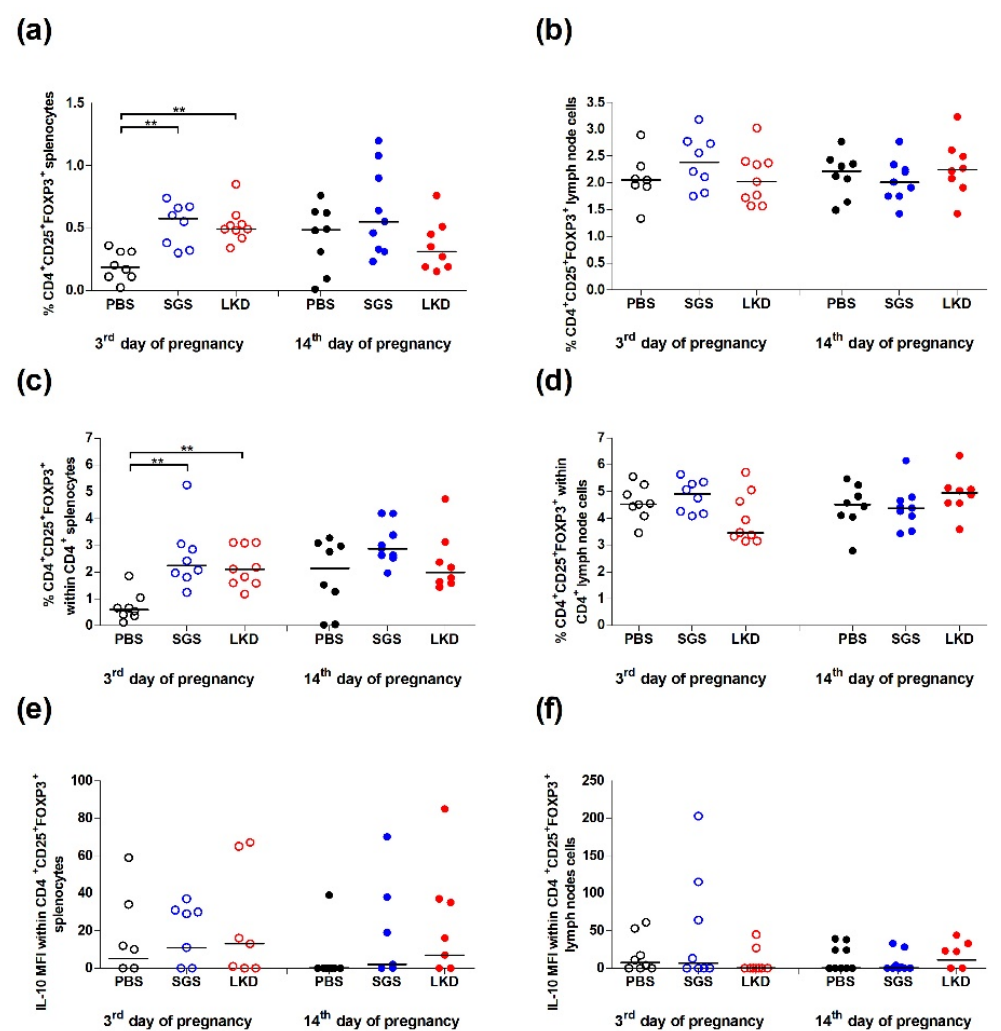
Figure 3. Frequencies of CD4 + CD25 + FOXP3 + ( a ) splenocytes and ( b ) uterine-draining lymph node cells among the ( c ) CD4 + splenocytes and ( d ) CD4 + lymph node cells, respectively, of the SGS-treated and LKD-treated groups at 3 dpc and 14 dpc in abortion-prone mice. The median fluorescence intensity (MFI) of IL-10 in the CD4 + CD25 + FOXP3 + ( e ) splenocytes and ( f ) uterine-draining lymph node cells of the SGS-treated and LKD-treated groups at 3 dpc and 14 dpc in abortion-prone mice. Data were analyzed using one-way analysis of variance (for normally distributed data), followed by Bonferroni’s multiple comparison post hoc test or the Kruskal–Wallis test (for non-normally distributed data), followed by Dunn’s multiple comparison post hoc test ( p < 0.05). Data are presented as individual values with the median. ** p < 0.01.